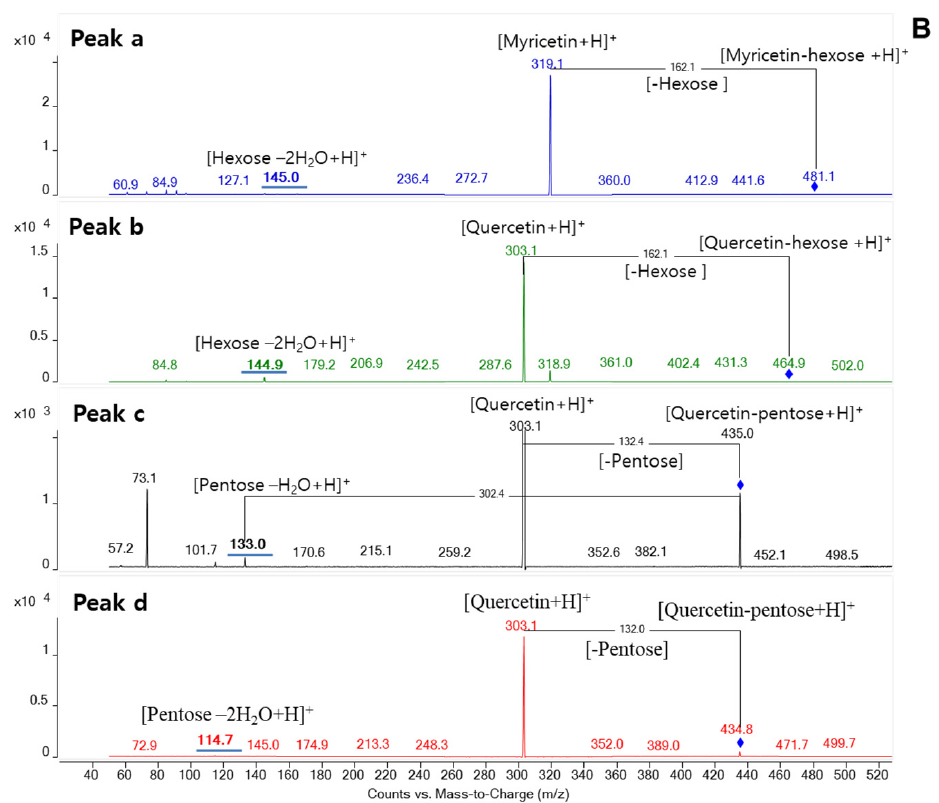
Figure 1. ( A ) The total ion (TIC), UV, and extracted-ion (EIC) chromatogram in the positive scan mode, ( B ) The product ion scan (PIS) chromatogram of flavonoids in Syzygium formosum leaves (1-catechin, 2-EGCG, 3-myricetin glucoside, 4-myricetin rhamnoside, 5-muercetin glucoside, 6-muercetin arabinoside, 7-muercetin rhamnoside, 8-quercetin; peaks from a–d: unknown flavonoids) .